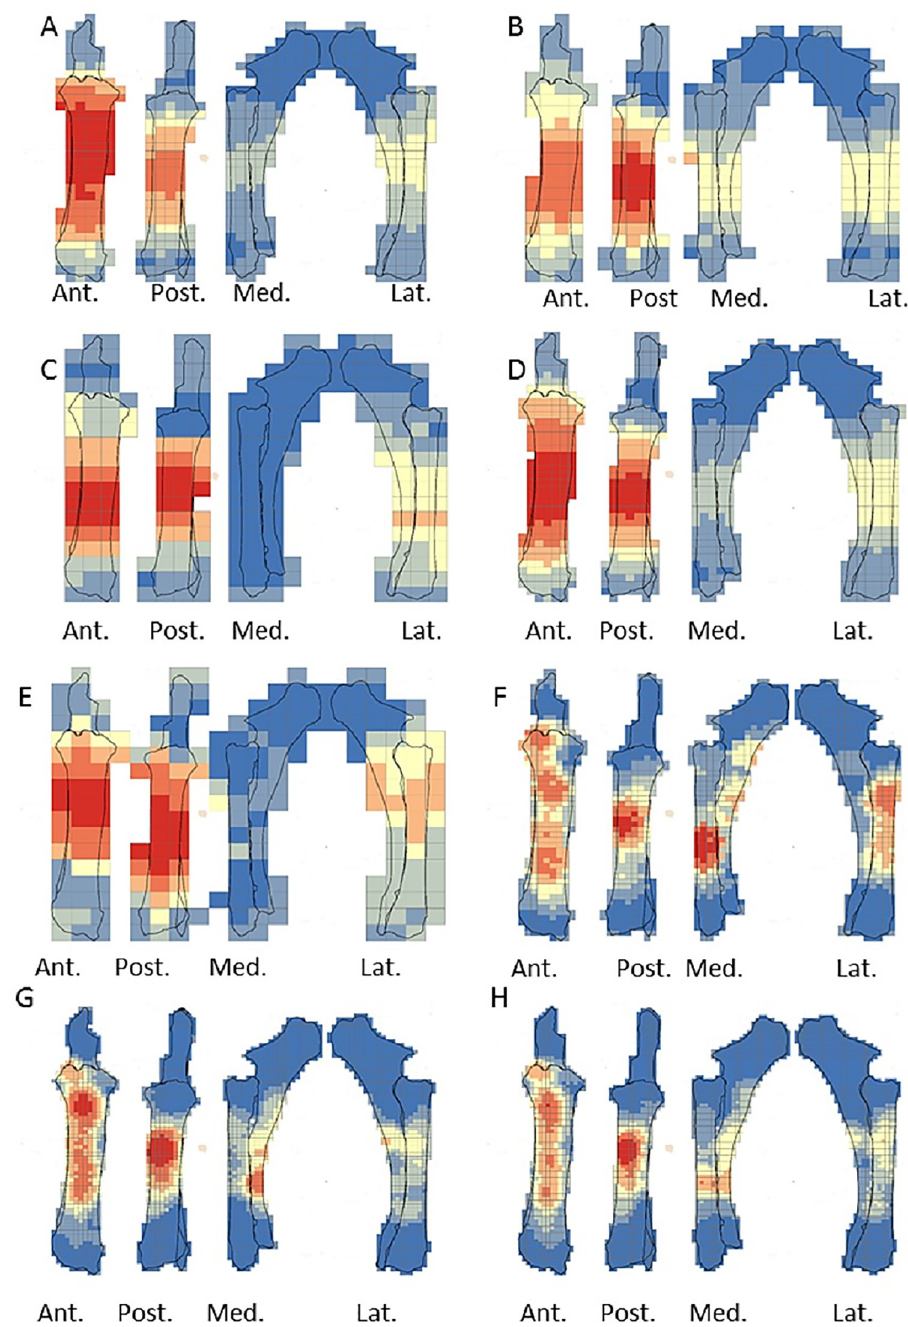
Fig 8. Optimized hot spot analysis of combined percussion marks from the radio-ulnas in each series. A-E- Individual n˚2; B-F- Individual n˚9; C-G- Individual n˚12; D-H- Merged radio-ulnas series; A, B, C and D: “CNA” Percussion marks and E, F, G and H: pits and grooves (Ind.: